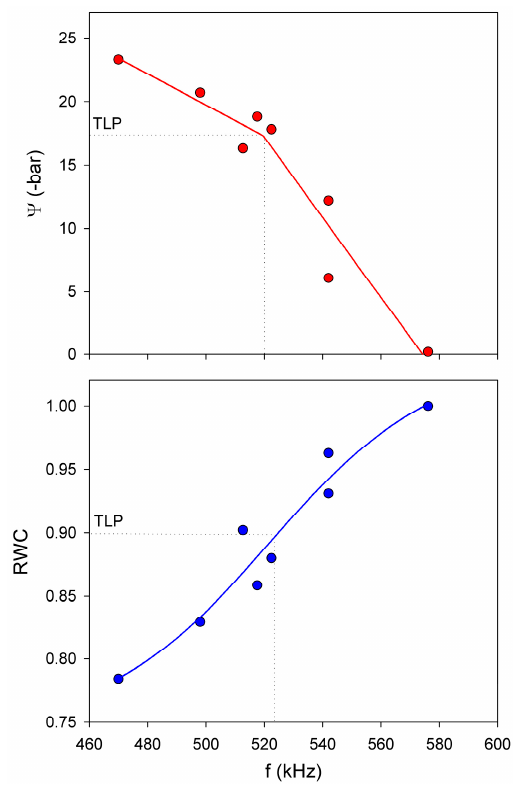
Figure 13. Relationships between f res (f) with Ψ and RWC for a Vitis vinifera cv. Grenache leaf. Dotted line indicates the turgor loss point (TLP).